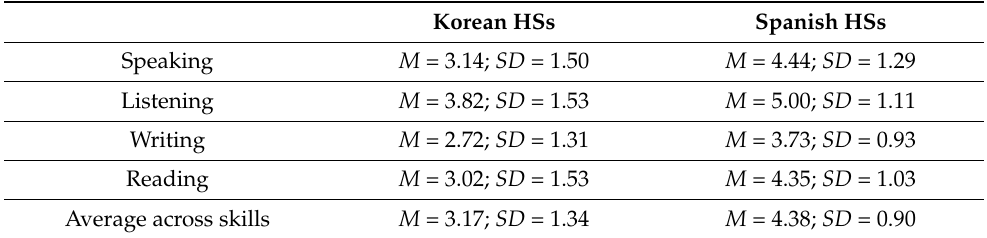
Table 2. Self-rated proficiency in the HL across skills and heritage speaker (HS)